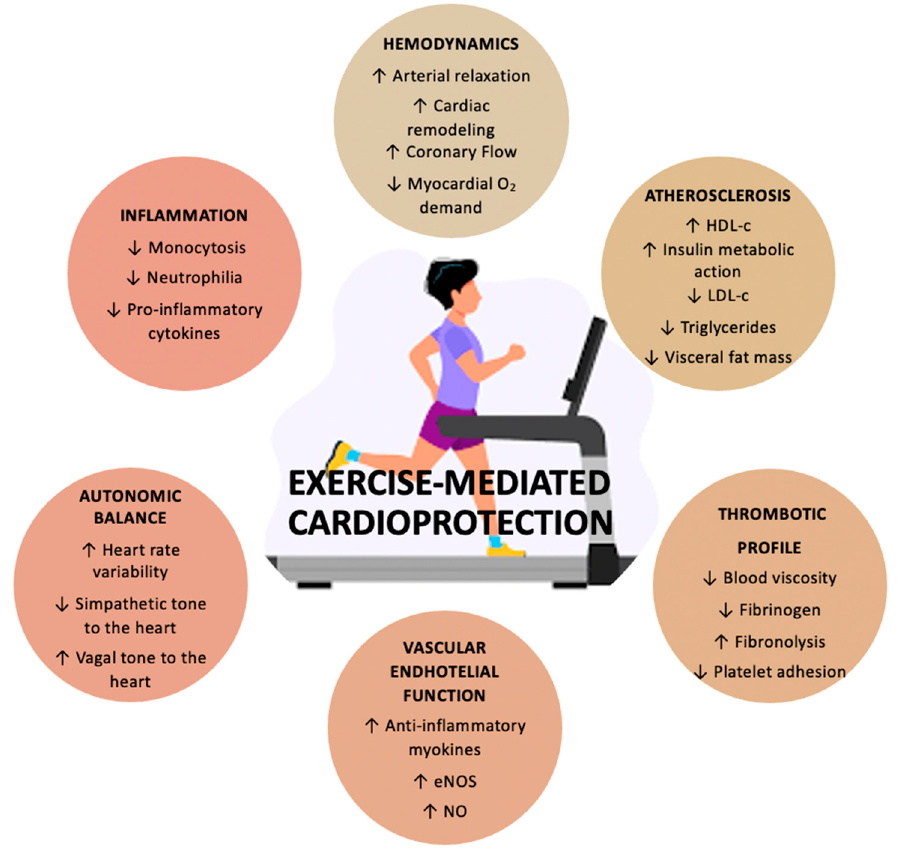
Figure 1. Exercise mediated protective effects on the cardiovascular system. Abbreviations: eNOS: endothelial nitric oxide synthase; NO: nitric oxide; HDL-c: high density lipoprotein cholesterol; LDL-c: low density lipoprotein cholesterol.